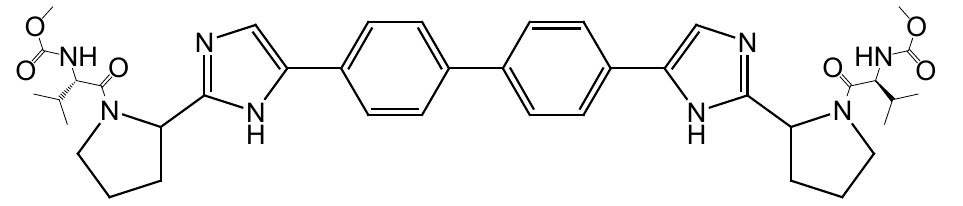
Figure 1: Structure formula of